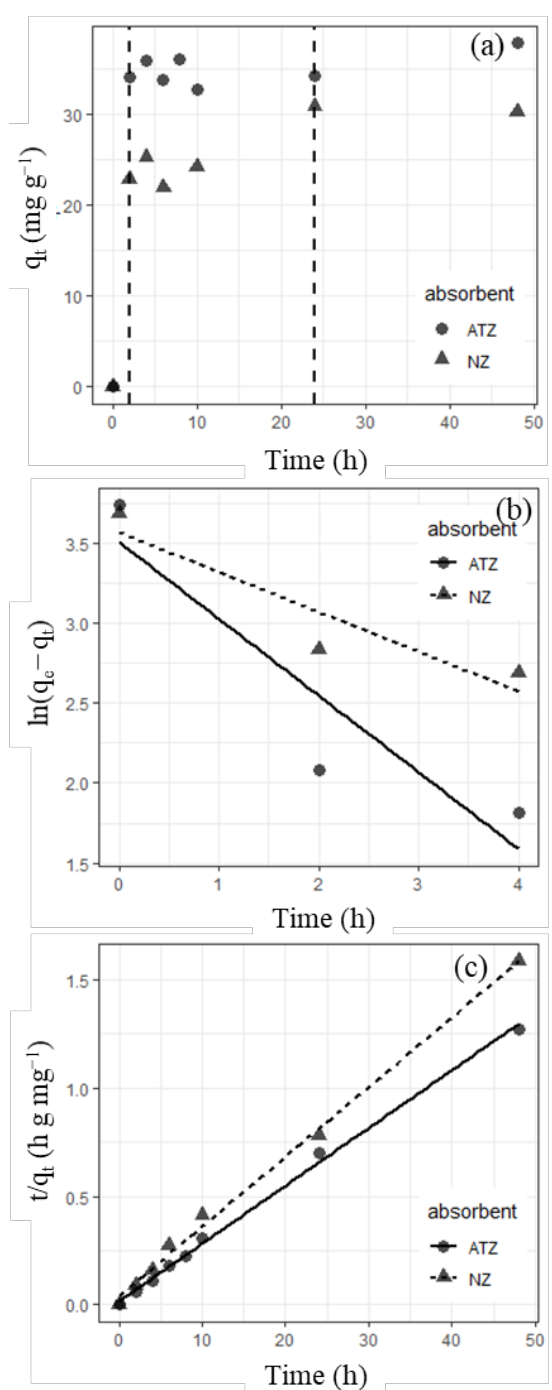
Figure 4. ( a ) Adsorbed amounts of potassium (K) on zeolite − based adsorbents with respect to time, (dashed line: the moments where each system reaches equilibrium); ( b ) the pseudo − first − order kinetics equation fitted to the 4 h K sorption data (solid line: ammonium acetate-treated zeolite, dashed line: natural zeolite); and ( c ) the pseudo − second − order kinetics equation fitted to the 72 h K sorption data (solid line: ammonium acetate − treated zeolite, dashed line: natural zeolite). For both the natural zeolite and the ammonium acetate-treated zeolite, not a single straight line could fit all the K sorption data over 48 h with the pseudo-first-order kinetics, since no further sorption was observed after 2 h. Thus, only the initial three data were fitted to the pseudo-first-order kinetics to derive the parameters (Figure 4b). This means